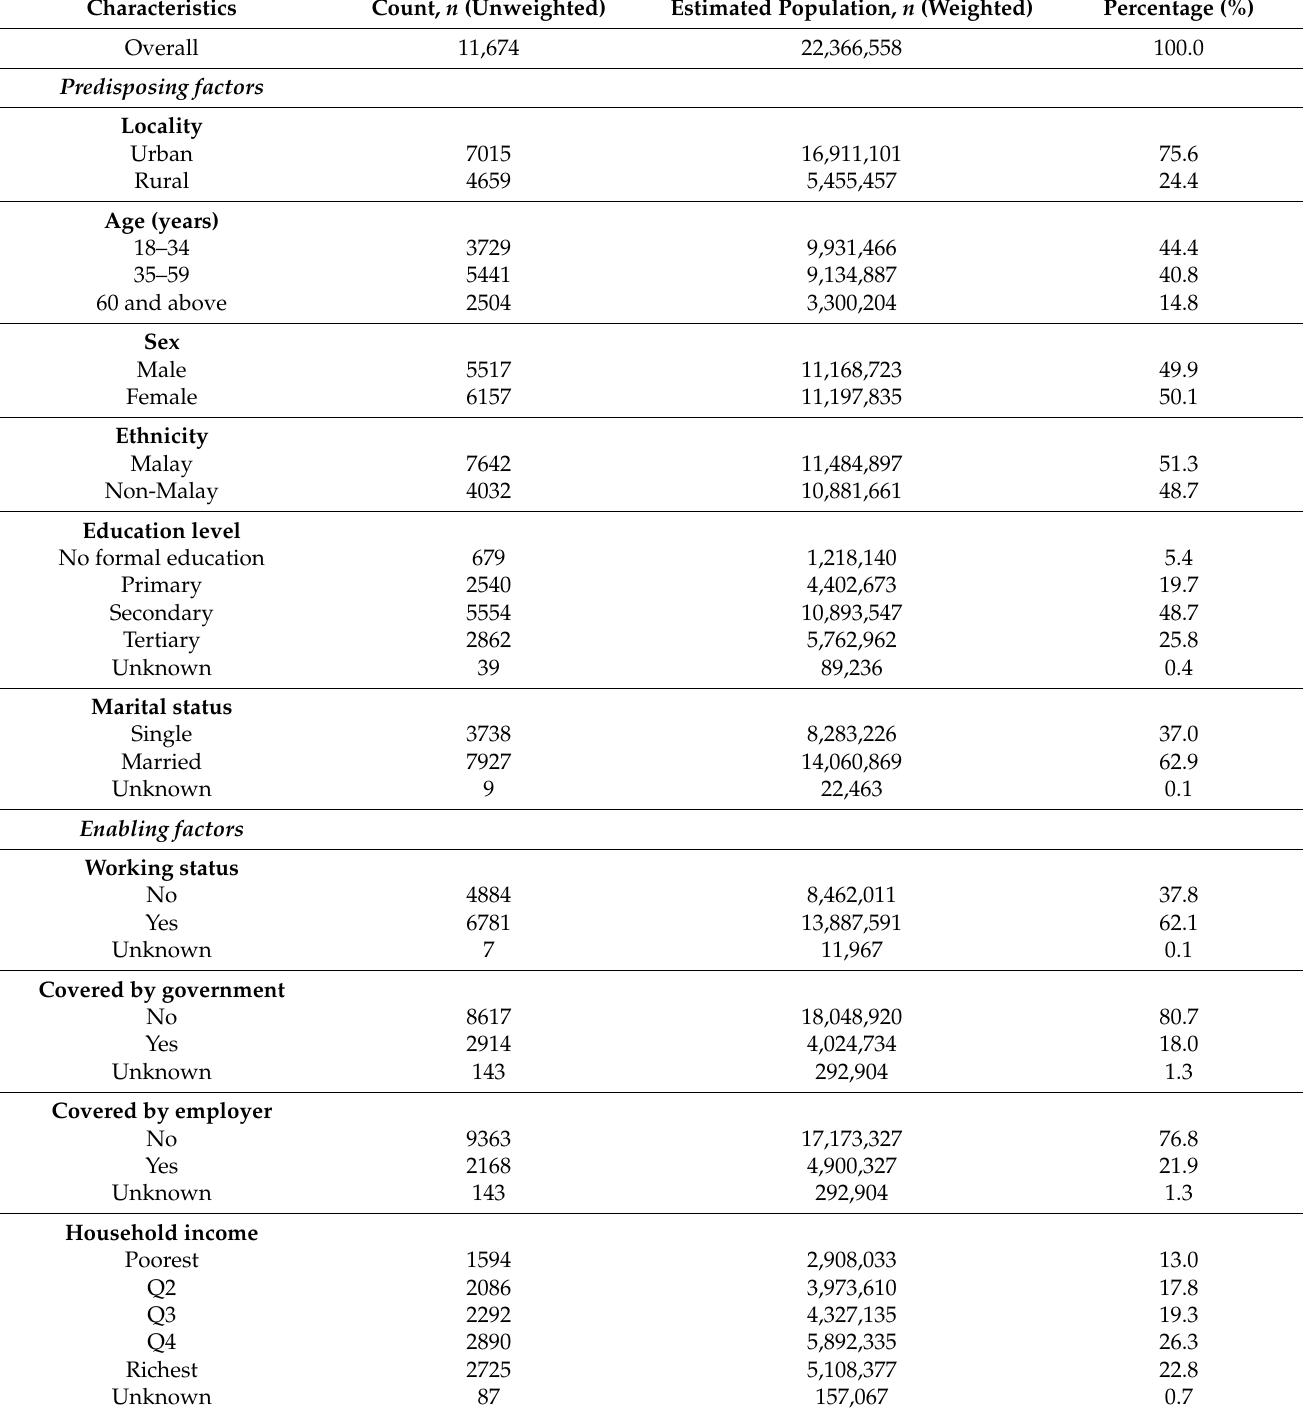
Table 1. Characteristics of the respondents (N =